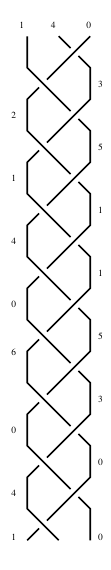
Fig. 6: Illustrative examples of non-trivial colorings of THK (3 , n ) ’s (end). A 7 -coloring of THK (3 , 8) with 7